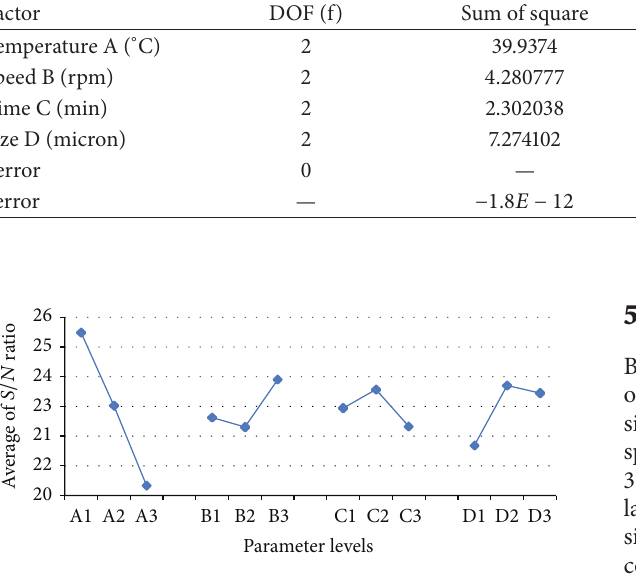
Figure 1: 𝑆/𝑁 response for processing parameters temperature (A), processing speed (B), processing time (C), and fiber size